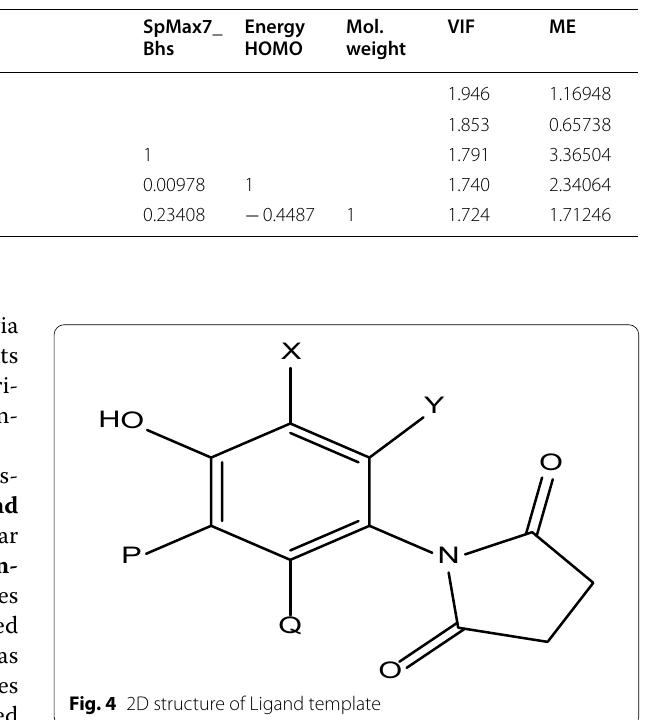
Table 7 Used molecular properties correlation matrix with VIF and mean effect